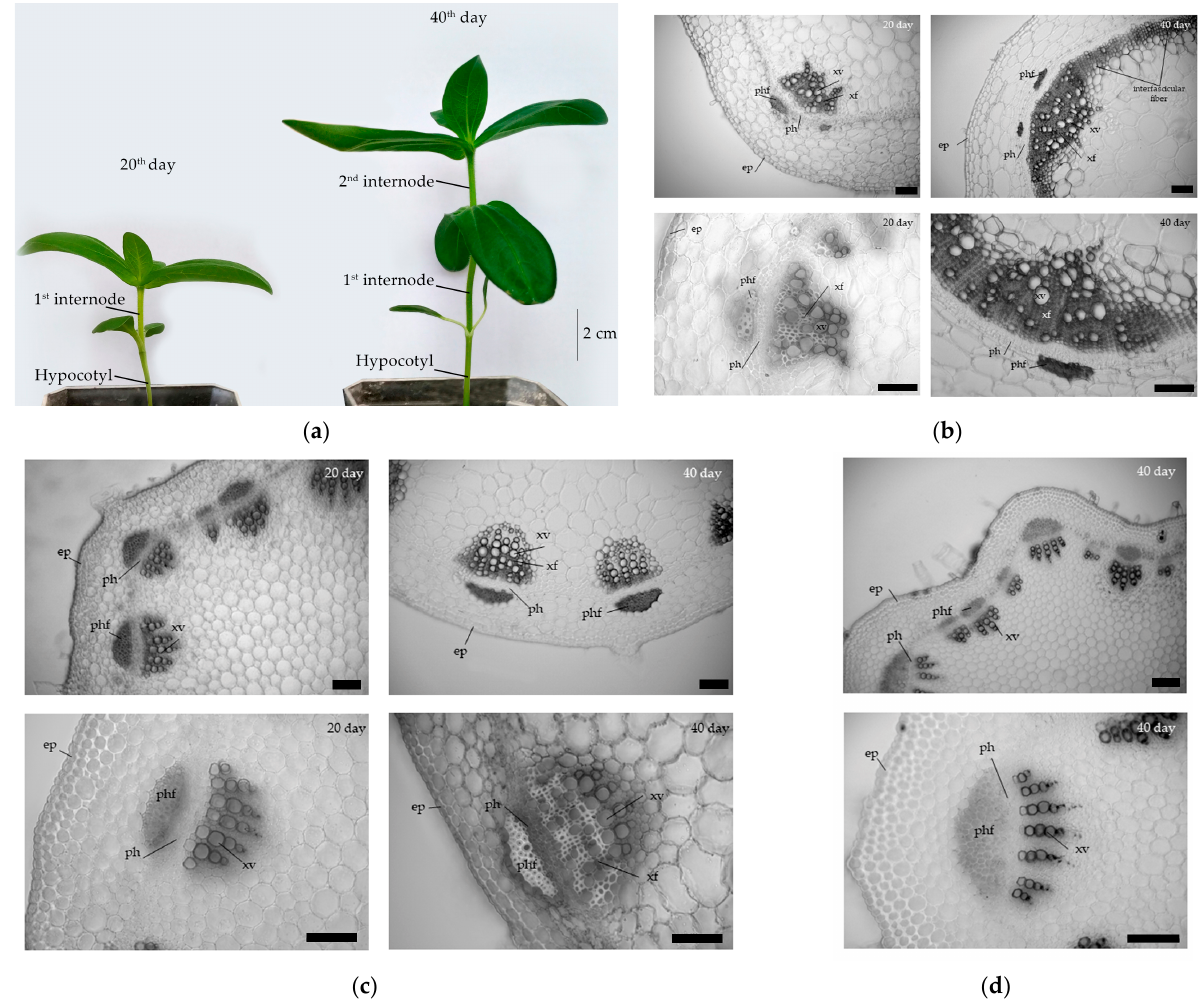
Figure 1. ( a ) Zinnia plants on the 20th and 40th days of growth. Cross sections of axial organs in 20- and 40-days-old zinnia: ( b ) hypocotyl—left 20th day, right—40th day; ( c ) first internode—left 20th day, right—40th day; ( d ) second internode—40th day. Lignin was stained with phloroglucinol hydrochloride. ep, epidermis; ph, phloem; xf, xylem fiber; xv, xylem vessel; phf, phloem fiber. Bar 100 µm. Table 2. The content of phenolic compounds and lignin in sections of the zinnia stem during radial